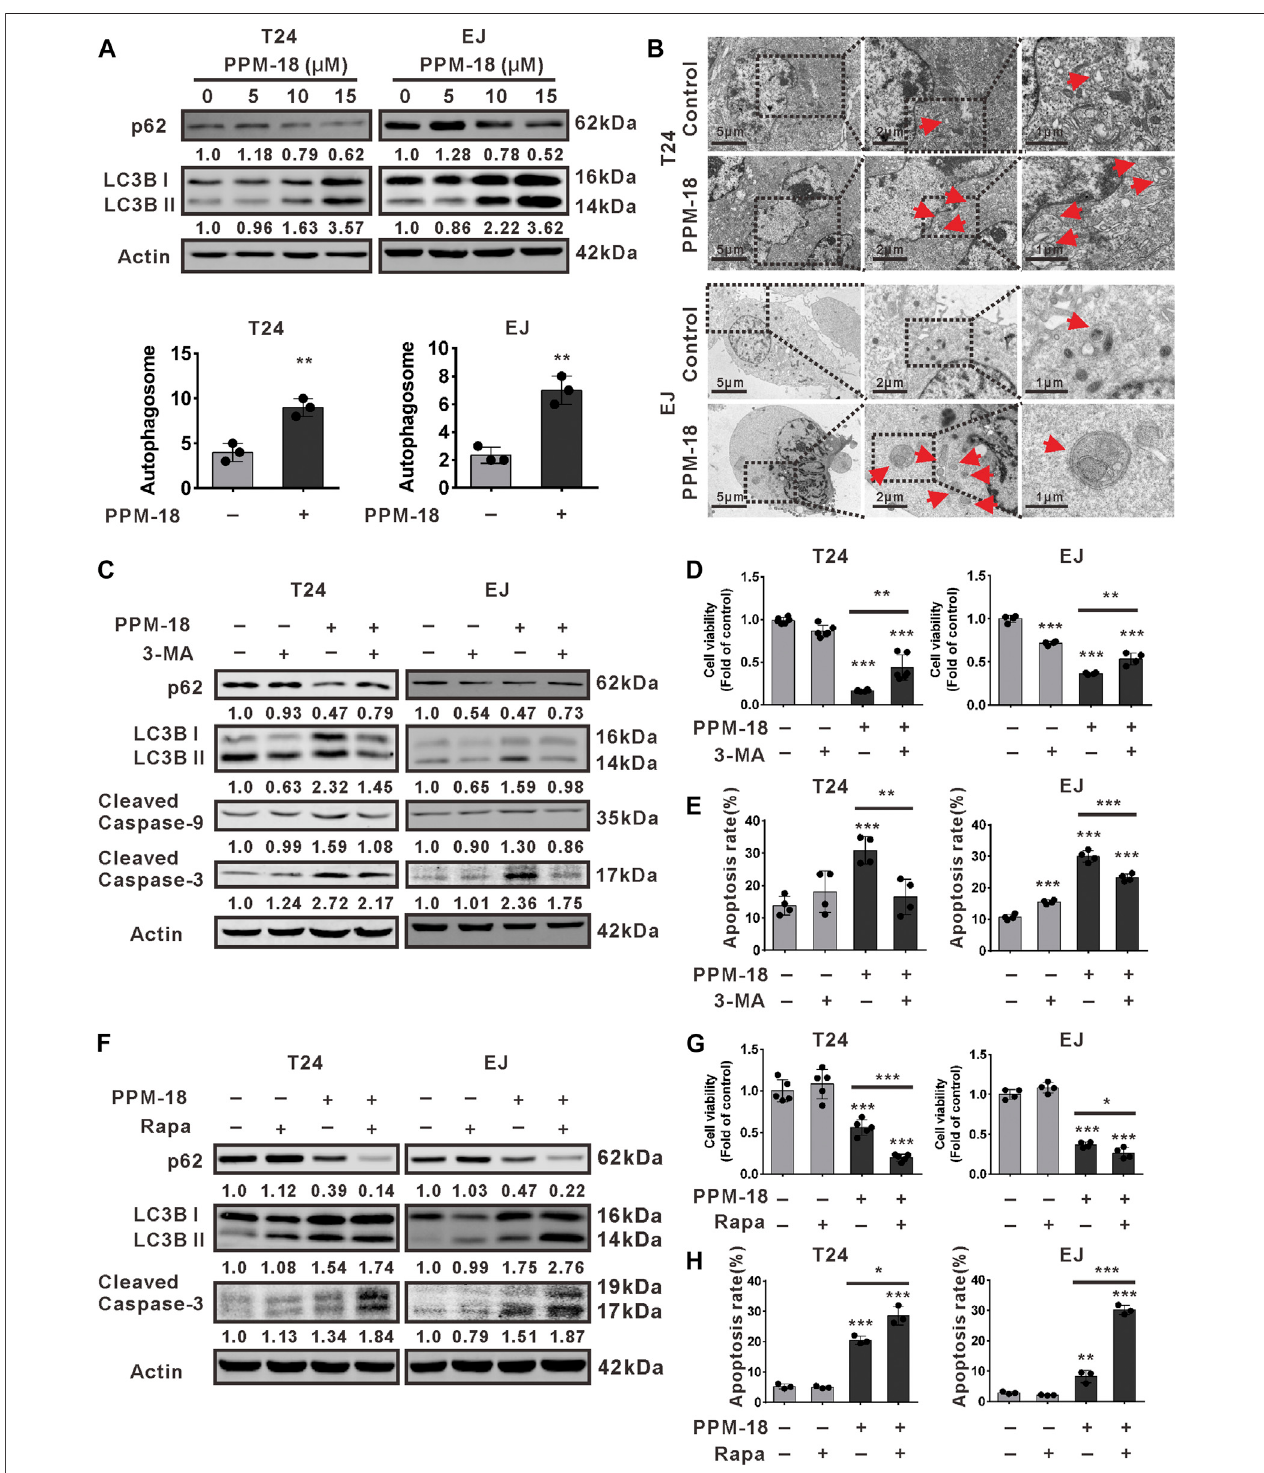
FIGURE3| PPM-18stimulatesautophagythatpromotesapoptosisinbladdercancercells. (A) T24andEJcellsweretreatedwithvariousconcentrationsofPPM- 18for24 h.Thencellswereharvestedforwesternblottingtodetecttheexpressionofp62andLC3B,twoautophagyindicators. (B) Theformationofautophagosomesin T24 and EJ cells treated with or without 10 μ M PPM-18 for 18 h under the transmission electron microscope. Arrows indicated the autophagosomes containing intact and degraded cellular debris. Scale bar: left: 5.0 μ m, middle: 2.0 μ m, and right: 1.0 μ m. (C) Western blot showed the effect of 5 mM 3-MA, a typical autophagy inhibitor,ontheexpression ofp62,LC3B,andcleavedcaspase-9,3inPPM-18 – treatedT24andEJcells. (D) and (E) T24andEJcellsweretreatedwith15 μ MPPM-18